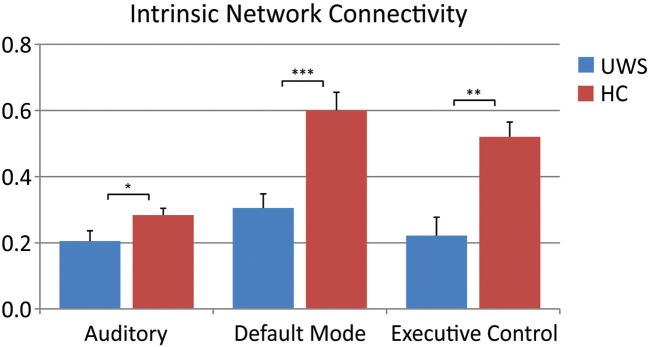
Comparison of intrinsic network connectivity between HC subjects and UWS patients during scanner noise for different RSNs (Mann-Whitney U-test: *p < 0.05; **p < 0.01; ***p < 0.001).